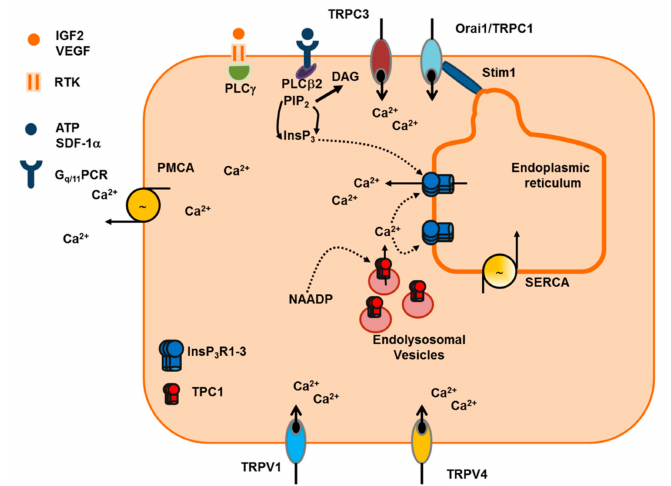
Figure 5. The Ca 2 + toolkit in endothelial colony forming cells (ECFC). Growth factors, such as VEGF, and chemokines, such as stromal derived factor-1 α (SDF-1 α ), bind to specific RTK and G q / 11 PCR, thereby activating multiple PLC isoforms, which in turn cleave PIP 2 into InsP 3 and DAG. InsP 3 triggers ER-dependent Ca 2 + release through InsP 3 R, while DAG gates TRPC3 exclusively in umbilical cord blood-derived ECFCs. SOCE is the major Ca 2 + entry pathway also in ECFC, in which it is mediated by the dynamic interplay among STIM1, Orai1 and TRPC1. Endogenous Ca 2 + release is further supported by NAADP, which evokes EL Ca 2 + release through TPC1. SERCA and PMCA contribute to maintain resting Ca 2 + levels and clear cytosolic Ca 2 + after a pro-angiogenic Ca 2 + signal. Pro-angiogenic Ca 2 + signals may also be delivered by TRP Vanilloid 1 (TRPV1) and TRPV4. See Section 5.2. (SDF-1 α ) and Section 5.3. (VEGF and NAADP) for further